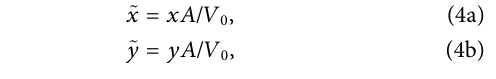
Frontiers in Physics |